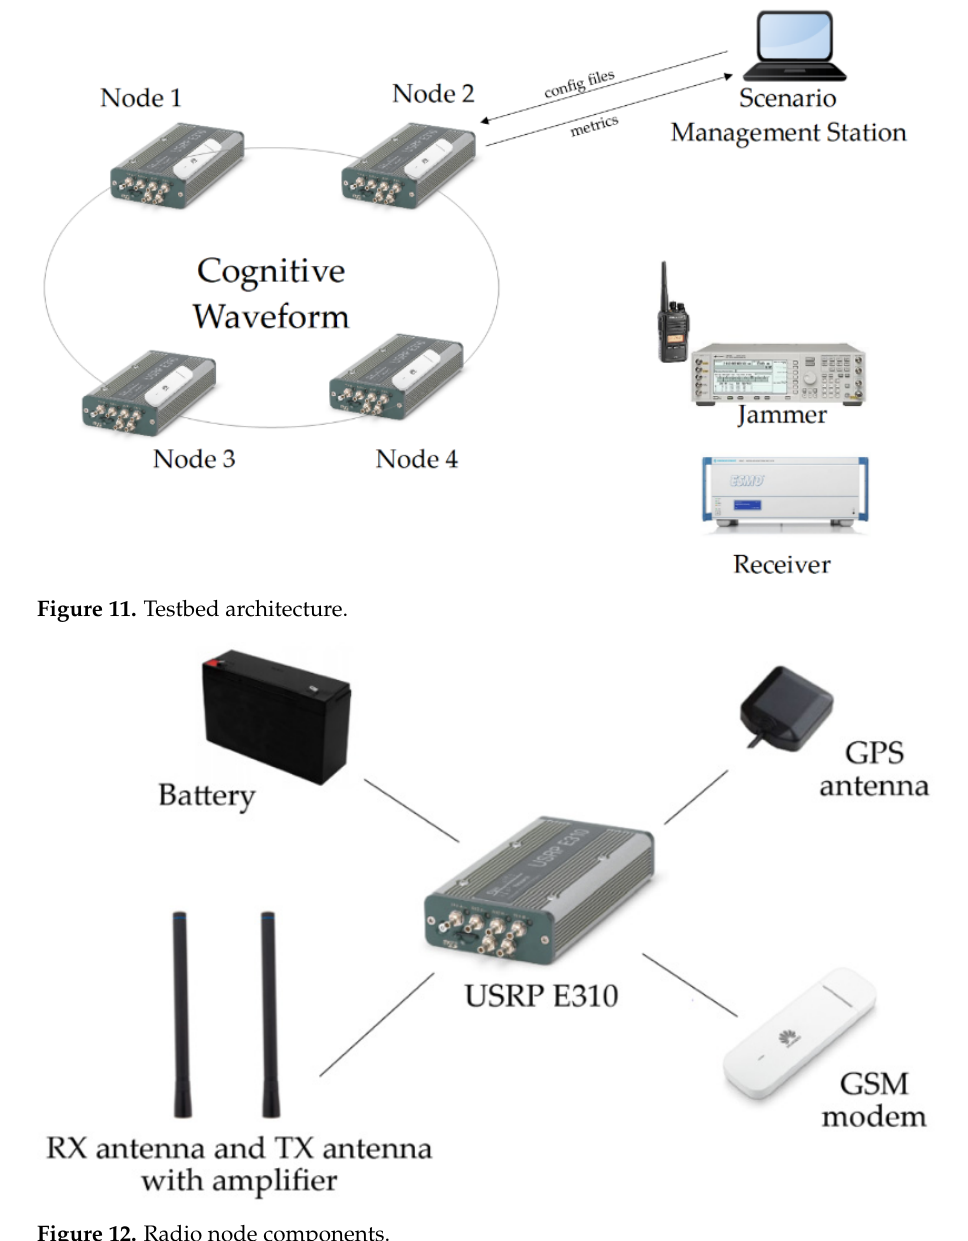
Figure 12. Radio node components.